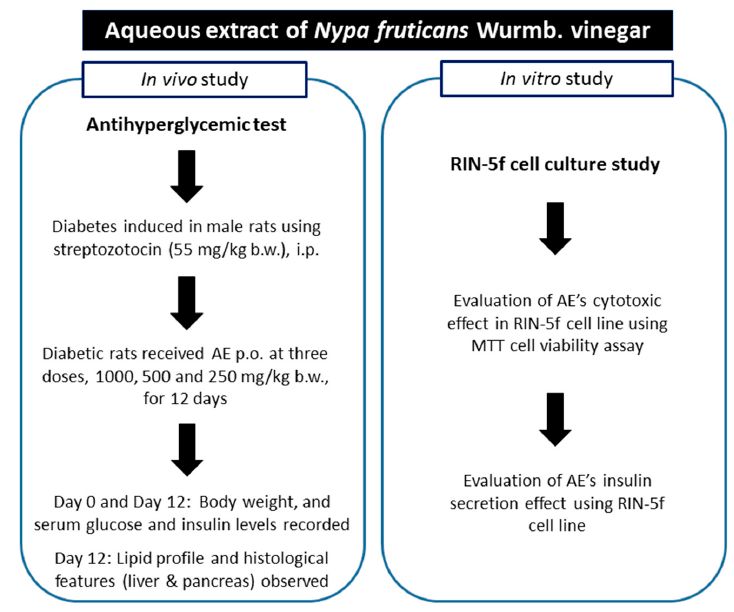
Figure 1. Overview of the experimental design.